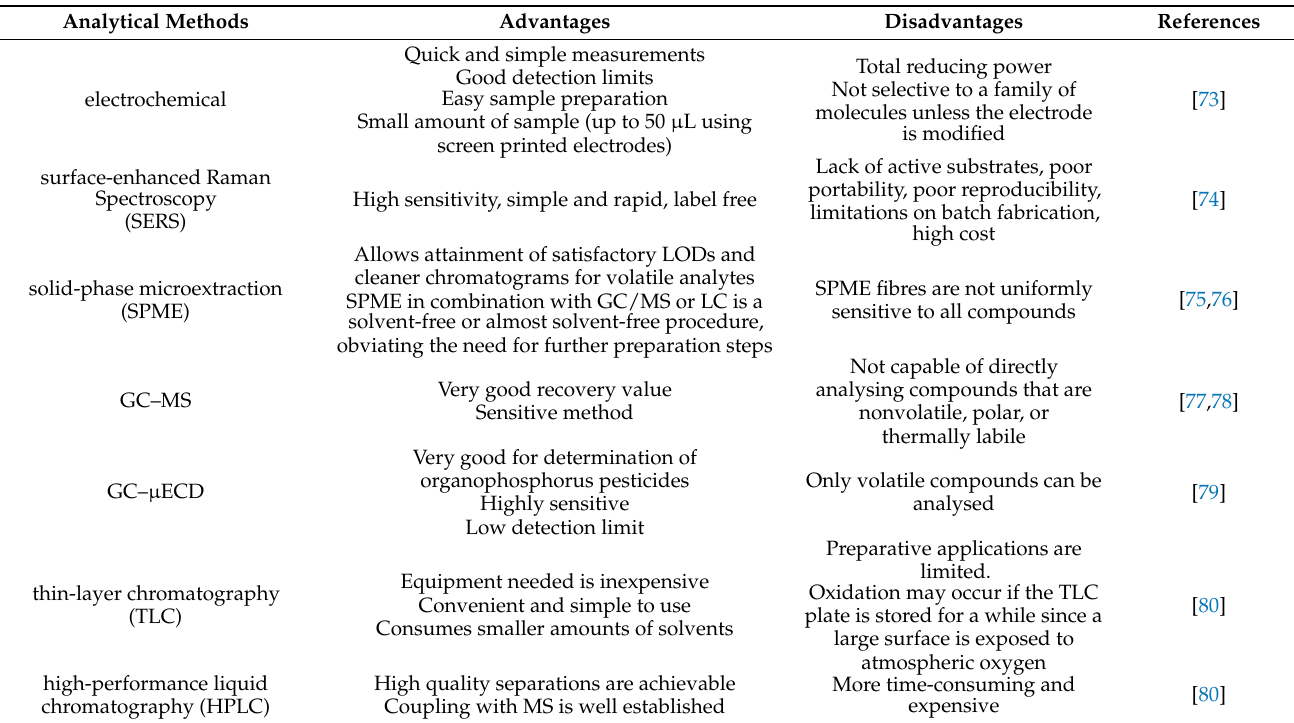
Table 8. Comparison of various analytical methods for OP and CM